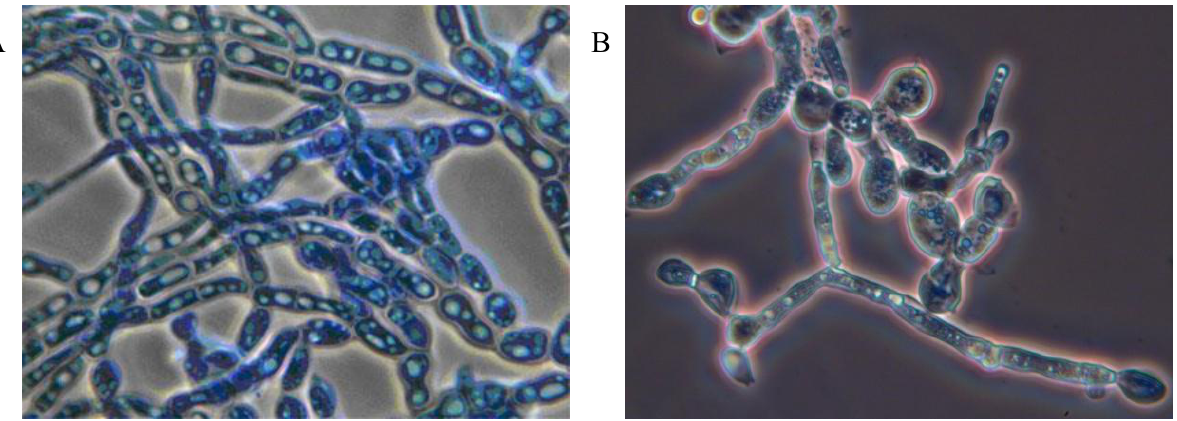
Figure 2. Myriangium duriaei in culture: mycelial mass ( A ), and formation of chlamydospores ( B ); cotton blue stain, objective ×100.